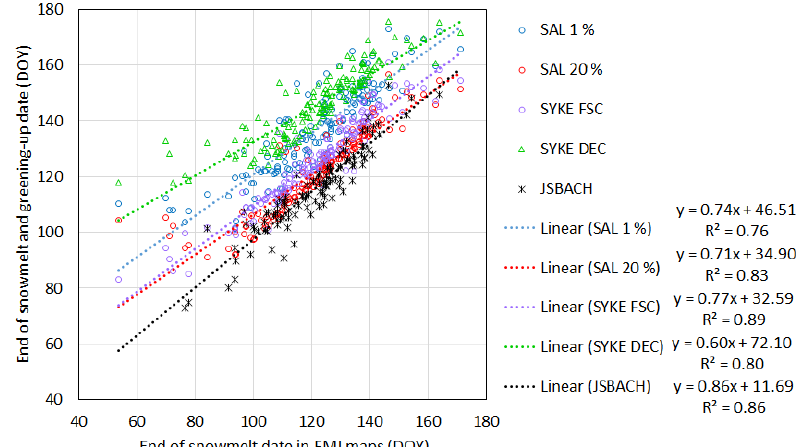
Figure 6. Comparison of diverse estimates of the melt-off day of snow cover. The FMI snow maps of end of permanent snow cover are based on in situ snow depth measurements. The satellite-based melt-off date estimates are derived using the surface albedo product CLARA-A2 SAL (Anttila et al., 2016a; Karlsson et al., 2017) and the FSC snow product calculated from MODIS images (Metsämäki et al., 2018). The JSBACH model estimate of end of snowmelt is also shown. For comparison the greening-up date of deciduous vegetation (SYKE DEC; Böttcher et al., 2016) is also presented.